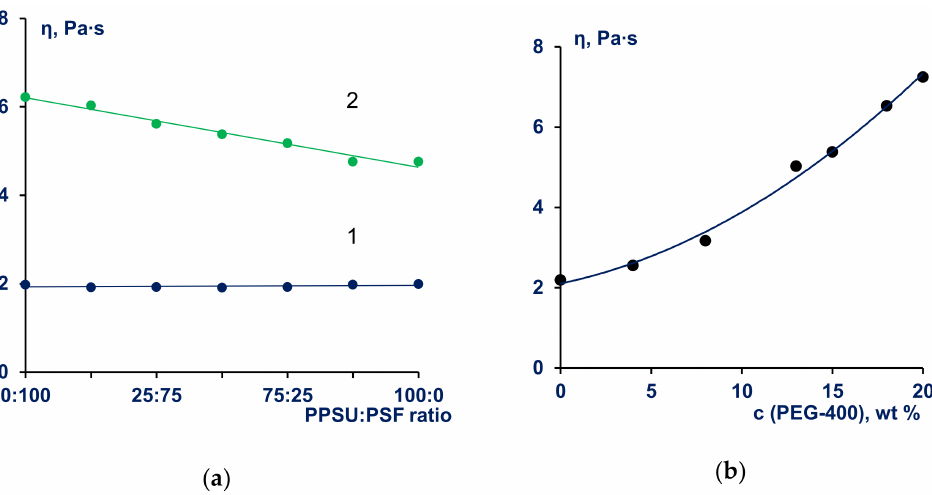
Figure 2. Viscosity of PPSU/PSF blend solutions in NMP: ( a )—dependence of dynamic viscosity ( η ) of 20 wt% polymer solutions in NMP on PPSU/PSF blend ratio, PEG-400 concentration: 1–0 wt%; 2–15 wt%; ( b )—variation of the viscosity of the PPSU/PSF/PEG-400/NMP solutions with PEG-400 concentration. PPSU/PSF blend ratio is